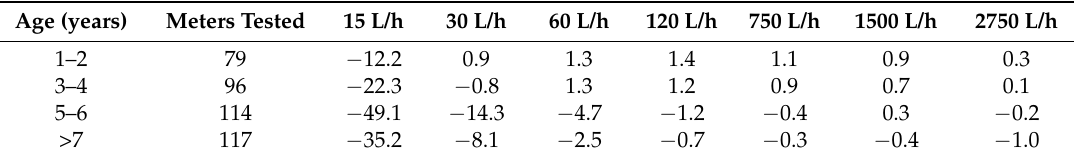
Table 3. The average error of indication (%) of meter type M_1 classified by age.